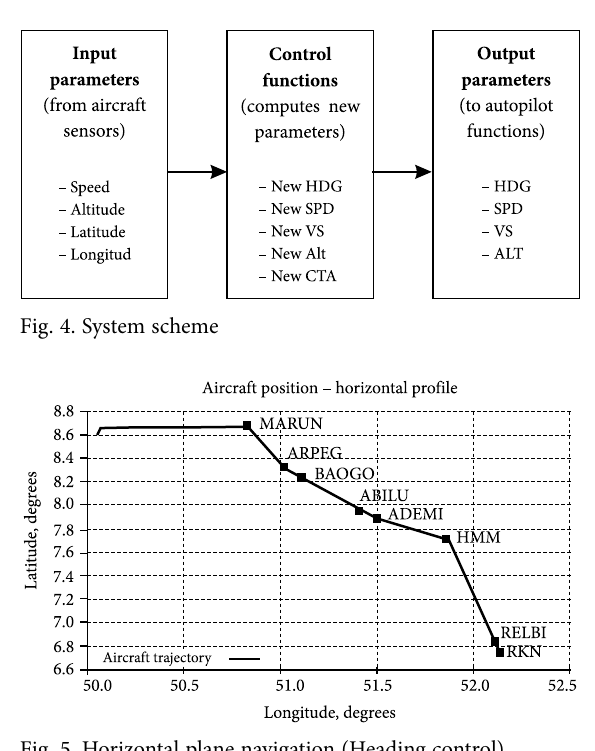
Fig. 5. Horizontal plane navigation (Heading